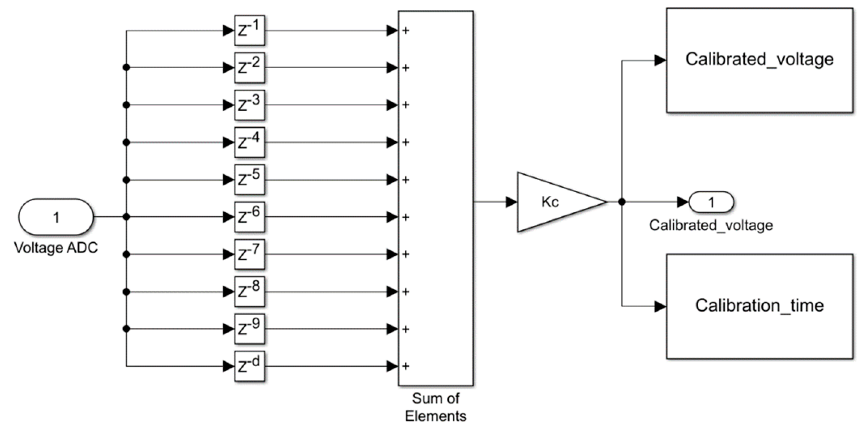
Figure 13. Voltage sensor calibration.